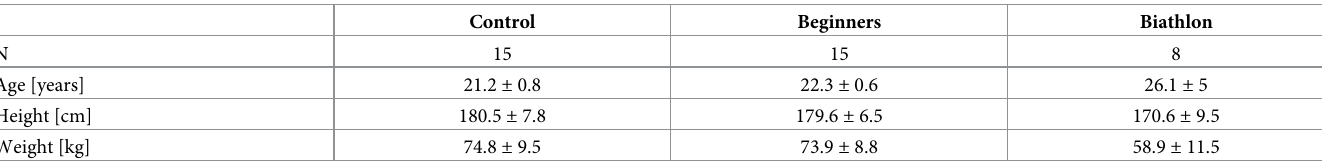
Table 1. Characteristics of the experimental